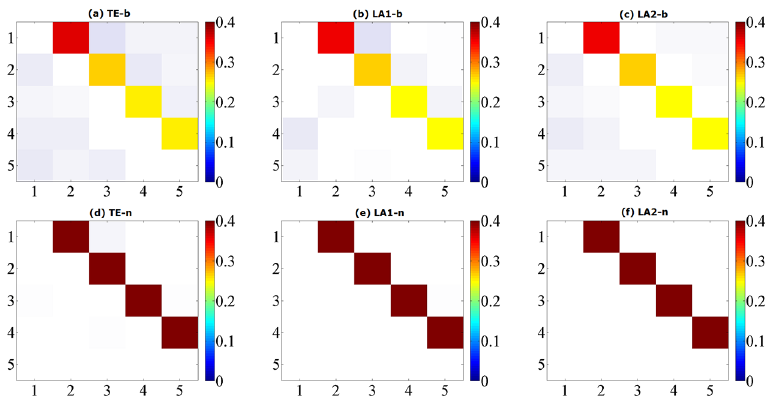
Fig 9. Matrix representations of the corresponding causalities for Model E. Retrieved by traditional TE method and two low-dimensional approximation methods, respectively by using binning entropy estimator (a, b, c) and NN entropy estimator (d, e, f) over 100 simulations of 1024 time points. The results are shown with color revealing the magnitude and transparency indicating the significance. The directions of causal influence are from row to column.